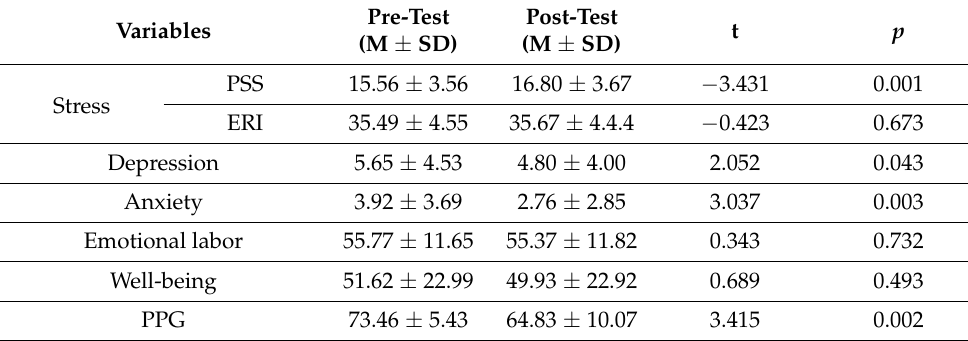
Table 2. Comparison of Pretest and Posttest (N =